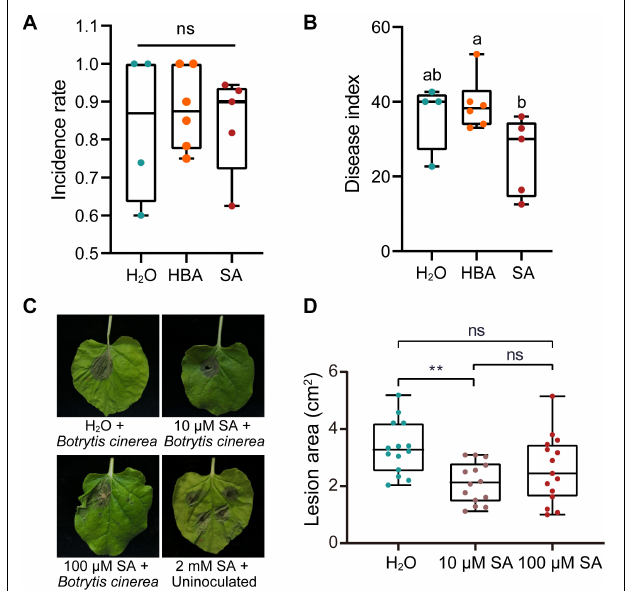
FIGURE 4 | The effect of salicylic acid on the infection of plants by pathogens. (A) The incidence rate of mulberry fruit used for spraying with SA or HBA. The incidence rate and disease index of diseased mulberry in all groups were consistent ( n ≥ 4). HBA, 3-hydroxy benzoic acid. H 2 O, Control group, sprayed with double distilled water. (B) The effect of spraying with SA or HBA on the disease index of infected mulberry fruits. The disease index of the diseased fruit was analyzed 7 days after spraying. Different letters (a, b) indicate statistical differences ( P < 0.05) ( n ≥ 4, one-way ANOVA with post hoc Duncan’s test). (C) The effect of injection with different of concentrations of SA on Nicotiana benthamiana with Botrytis cinerea infection. Tobacco leaves infected with B. cinerea were photographed at 4 days after inoculation. (D) Quantitative measurement of lesion size on tobacco leaves inoculated with B. cinerea . Asterisks indicate a statistically significant difference (** P < 0.01) according to Student’s t -test. Experiments were repeated at least three